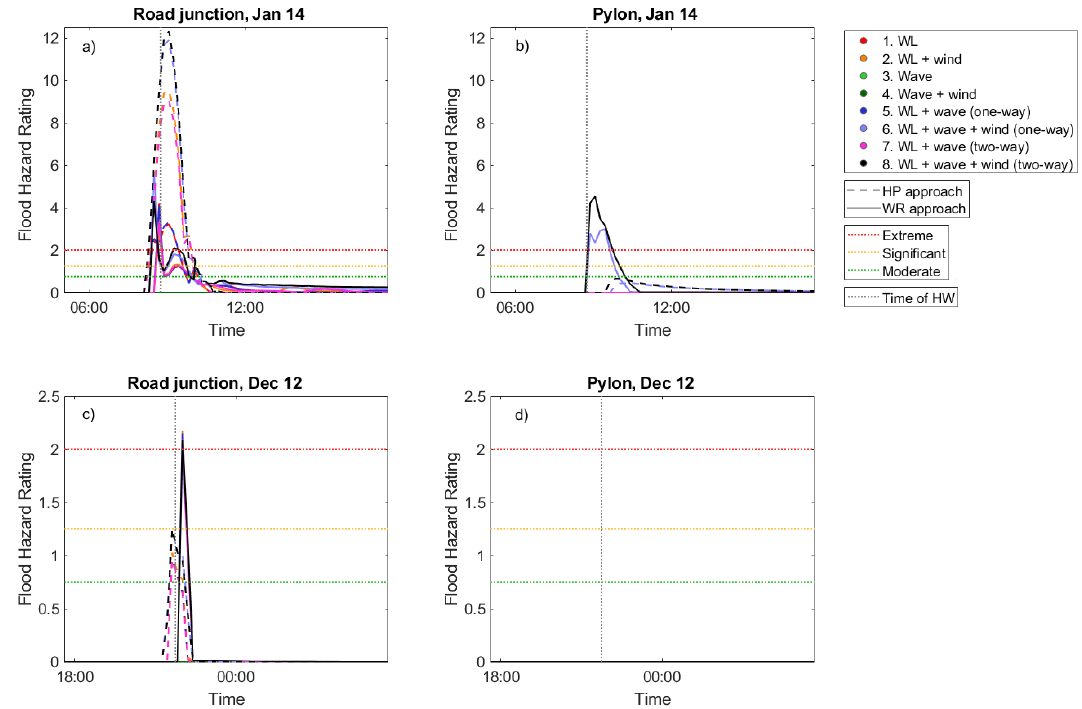
Figure 6. Flood hazard rating during the January 14 event at ( a ) road junction; ( b ) pylon; and during December 12 event at ( c ) road junction; and ( d ) pylon using the HP (dashed black line) and WR approach (solid black line). Modelled tidal signal at the boundary midpoint (vertical dotted black line) and extreme (red, horizontal dotted line), significant (amber, horizontal dotted line) and moderate (green, horizontal dotted line) thresholds for hazard to people [24].